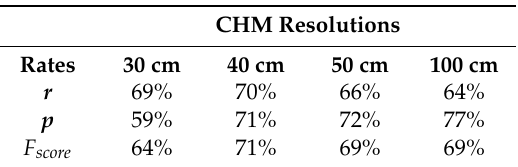
Table 3. Eucalyptus spp. tree (height > 10 m) detection rates (r) , using Equations (2)–(4), correctness of the detected trees ( p ), and overall accuracy (F score ) based on local maxima for 30 cm, 40 cm, 50 cm and 100 cm CHM resolutions derived from the Photomod gimbal flight data.